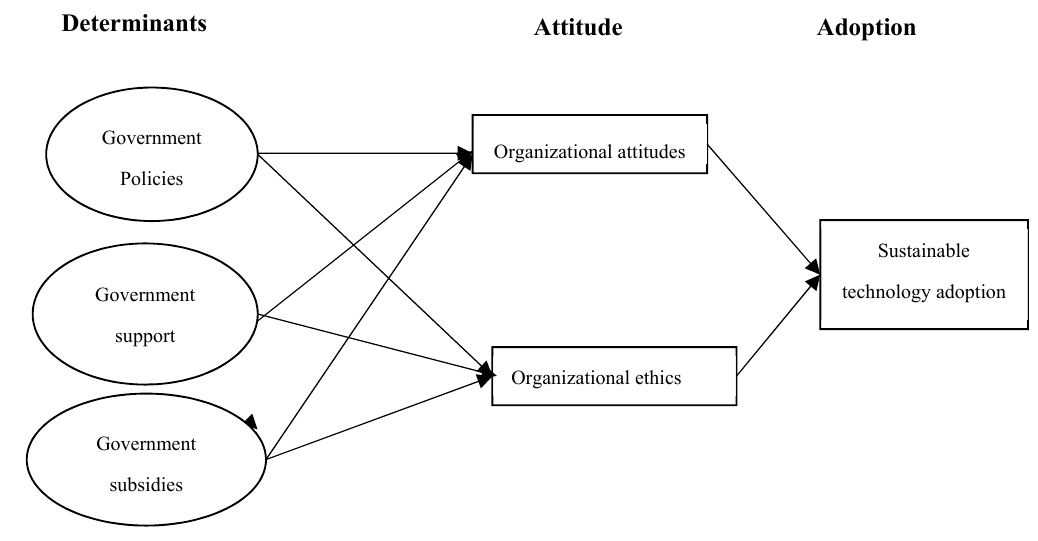
Figure 1. Theoretical Research Model.